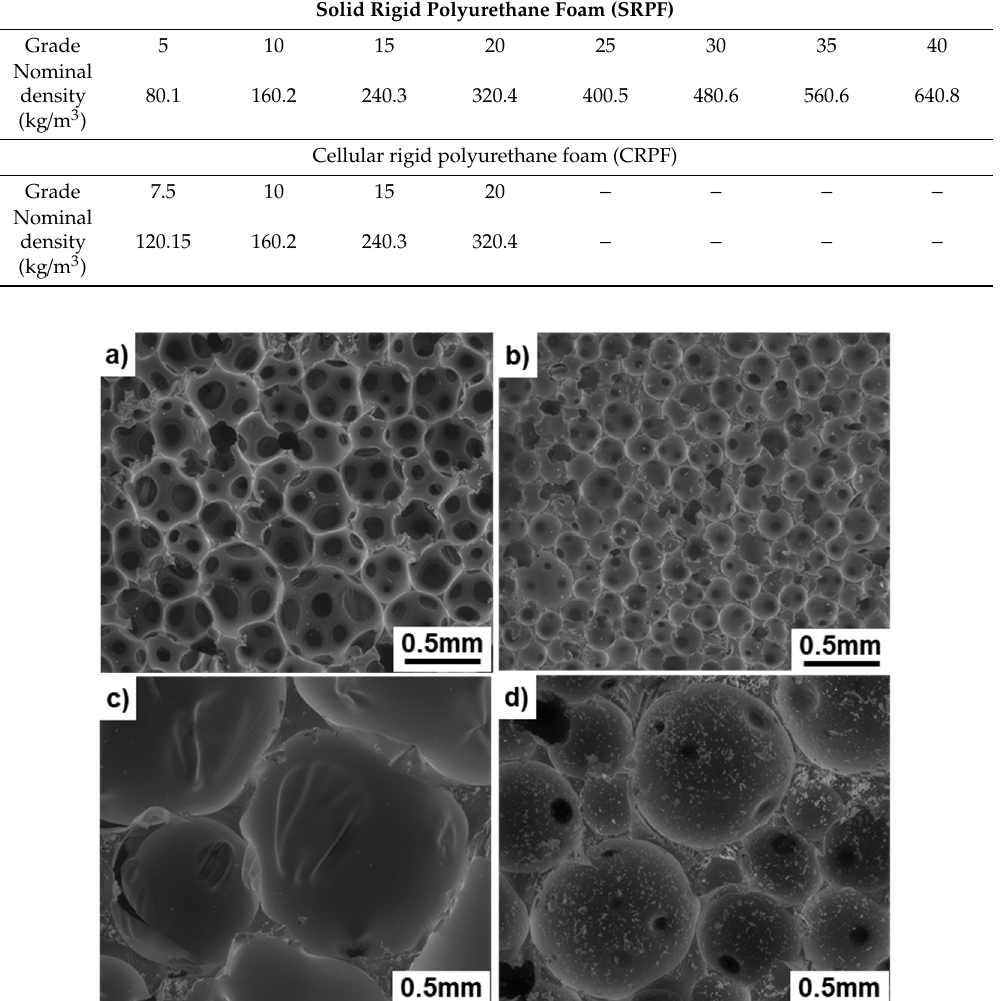
Table 2. Bone models used in this study.